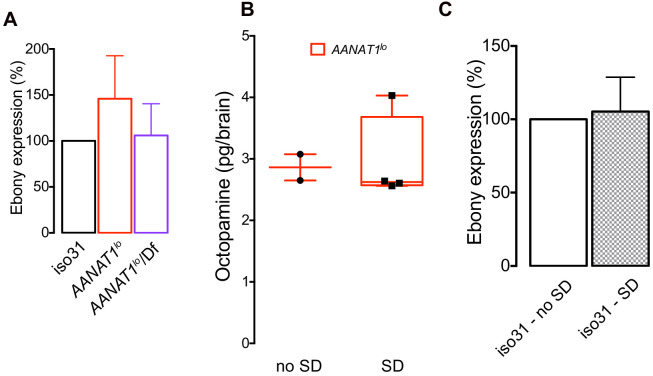
Characterization of AANAT1lo.(A) Quantification of Ebony expression normalized to that of actin (mean + standard deviation, n = 3 biological replicates, one-way ANOVA with Tuckey’s post-hoc test). (B) HPLC-MS measurement of octopamine (Mann-Whitney test, p<0.533) in AANAT1lo animals under control (n = 2) and SD (n = 5) conditions. Box and whisker plot as in Figure 2F. (C) Quantification of Ebony (paired t-test, p=0.7036, n = 3) expression normalized to actin levels in iso31 animals under control and SD conditions.